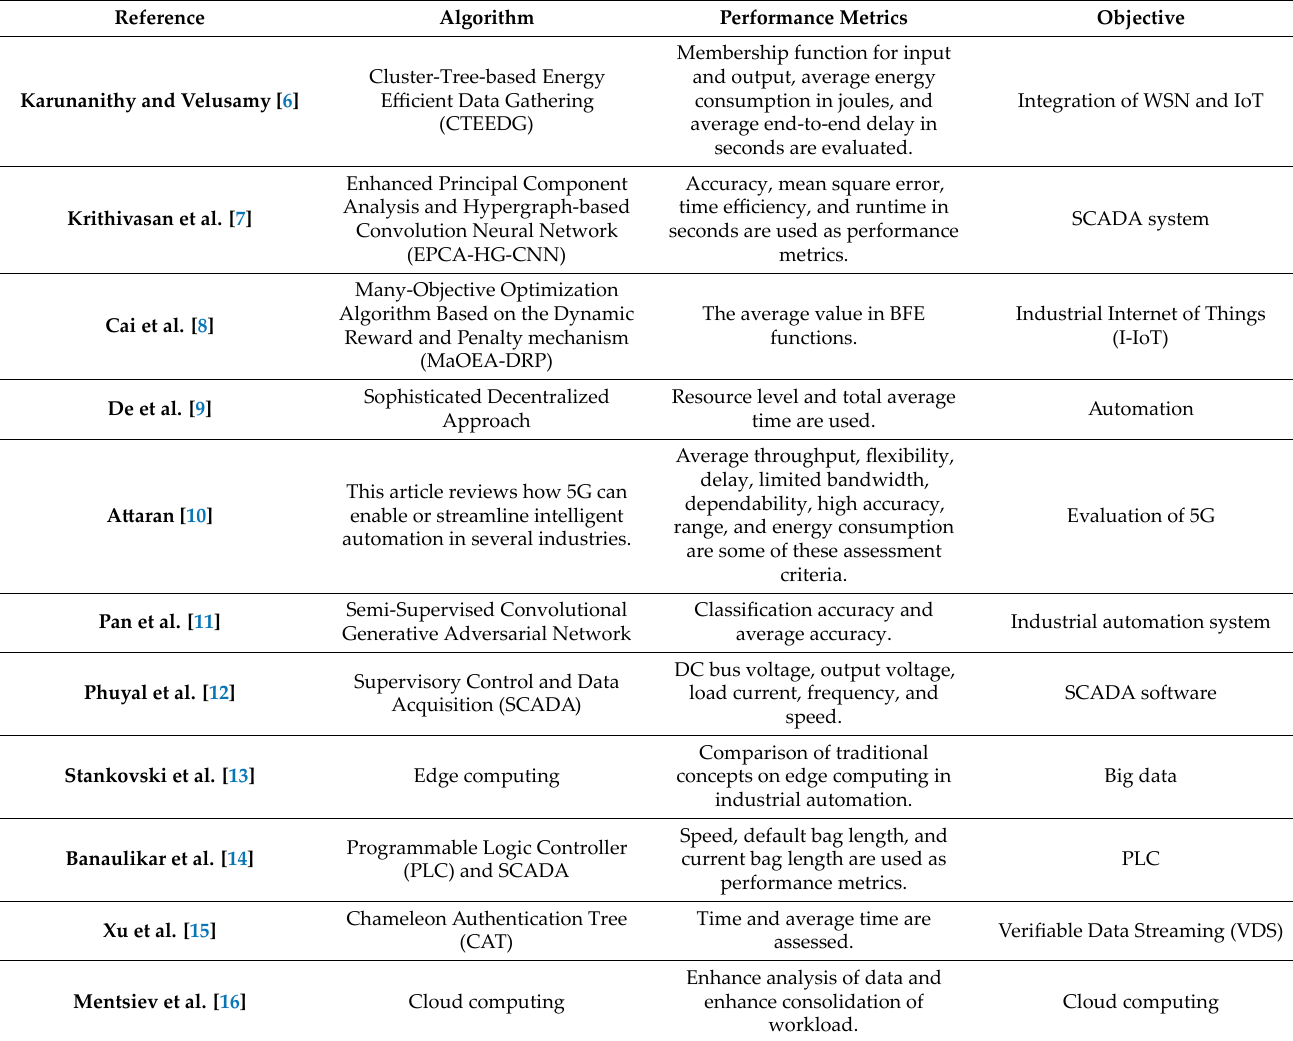
Table 1. The Summary of existing